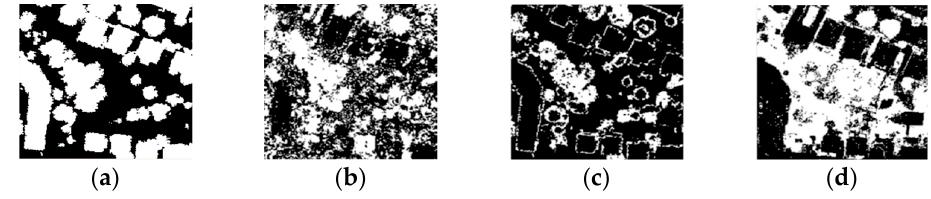
Figure 10. Single feature classification results : ( a ) FE; ( b ) IN; ( c ) HD; ( d ) NDVI.